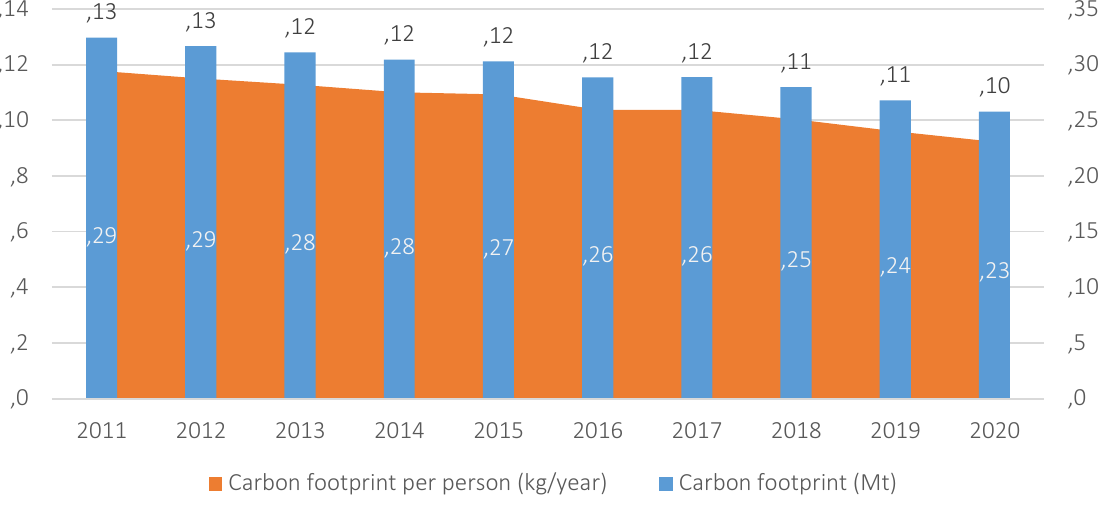
Figure 4. Carbon footprint of the smartphone market in the EU